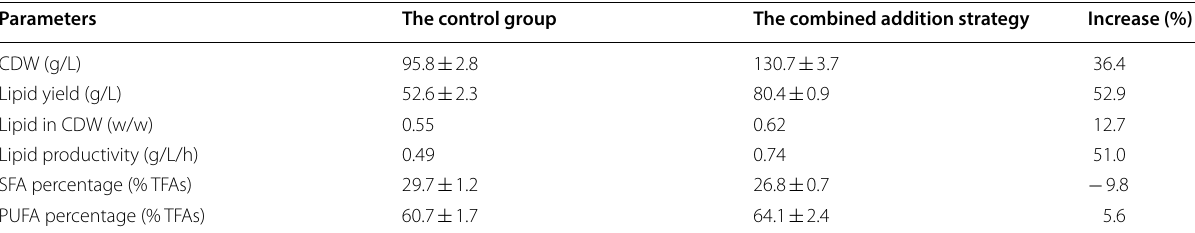
Table 3 Fermentation results of the combined strategy in a 5 L bioreactor and % changes compared to the same results from the control